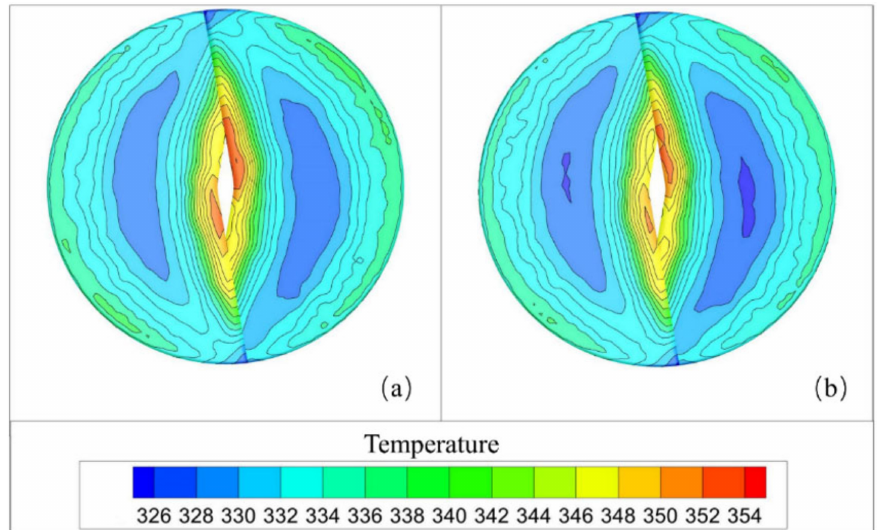
Figure 20. Simulation results considering temperature dependence of metal electrical conductivity: ( a ) electrical conductivity changing in response to temperature; ( b ) electrical conductivity not chang- ing in response to